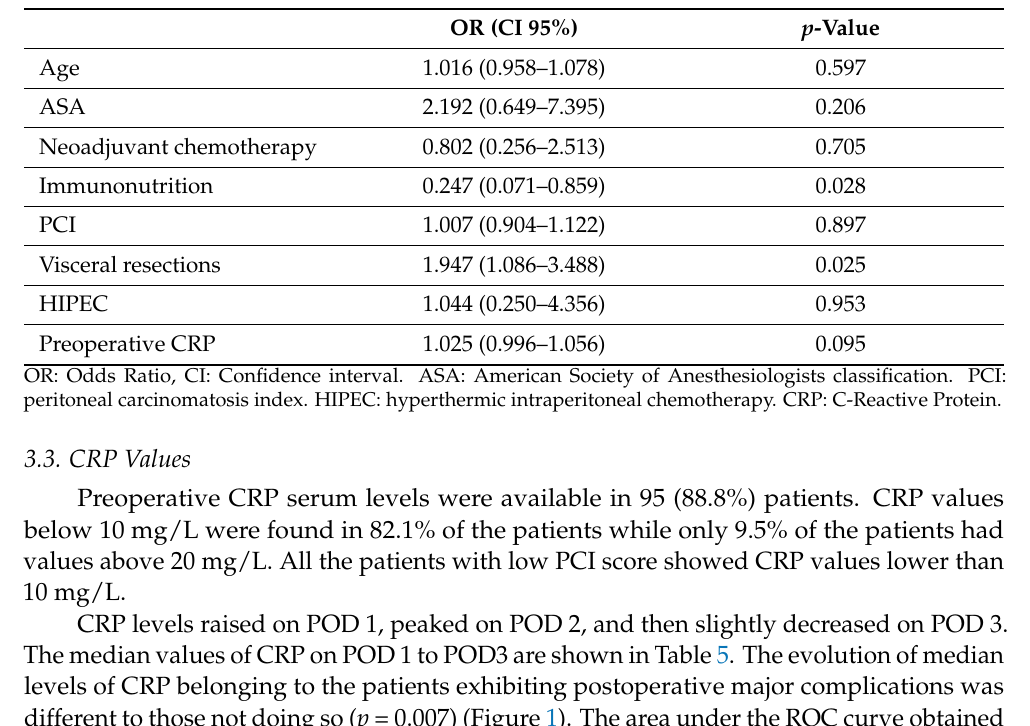
Table 4. Postoperative major complications. Binary Logistic Regression.